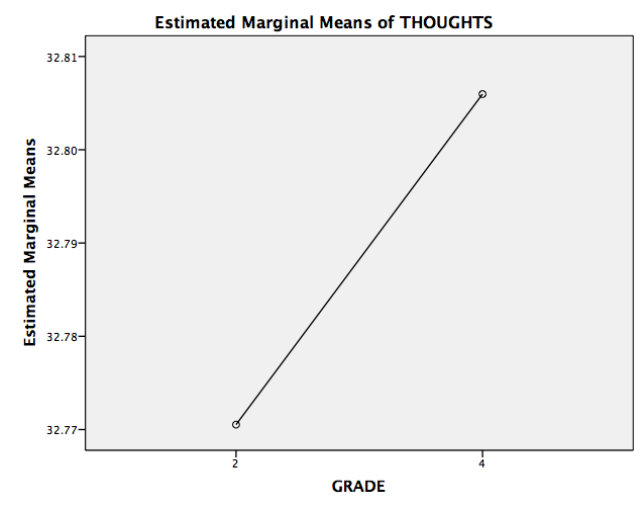
Figure 1. Profile plot of